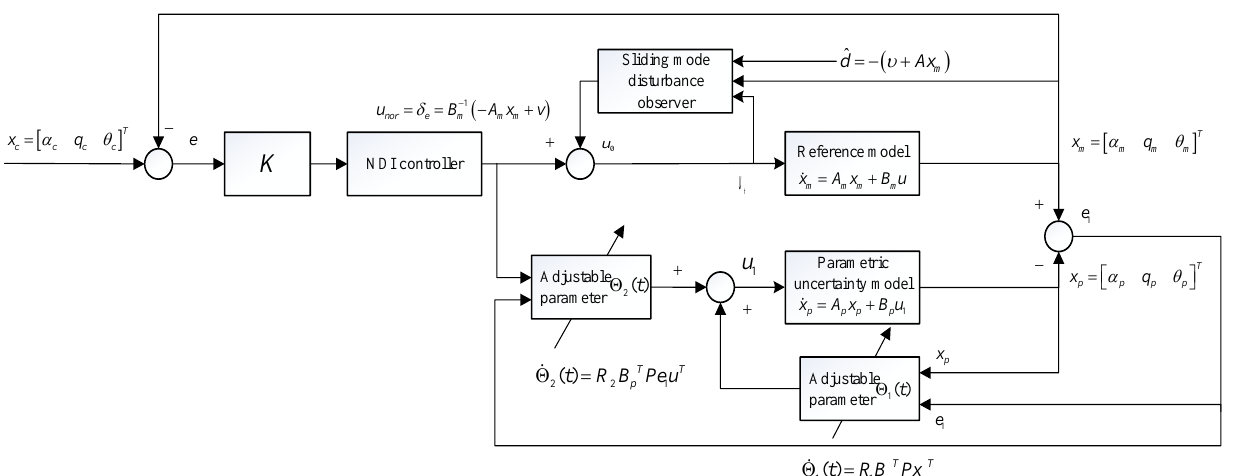
Figure 4. Overall diagram of longitudinal HFV model adaptive sliding mode NDI control.